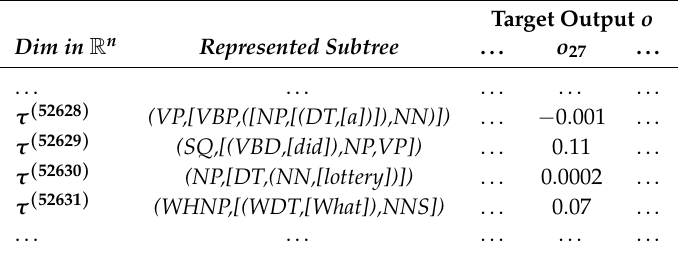
Table 2. Sample of a subtree space with activation of the target layer o